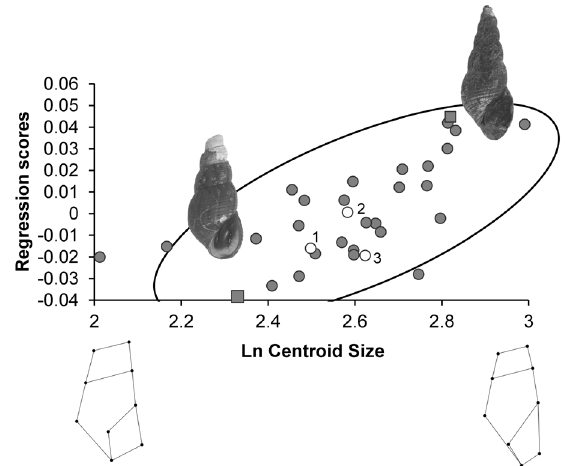
Figure 6. Multivariate regression between shell size (Ln centroid size) and shape of Melanoides tuberculata performed to detect allometry. Gray dots correspond to snails from La Carrindanga Road (Bahía Blanca city) and white dots correspond to those from other localities (1: Paraguay; 2: Argentina; 3: Brazil). Wireframe snails were generated to indicate the shape variation along size axis (scale factor: ±1); photographs correspond to the snails with the smallest and largest regression scores (gray squares) that were re-scaled to the same shell length. Equal-frequency ellipse contains ca. 90% of the